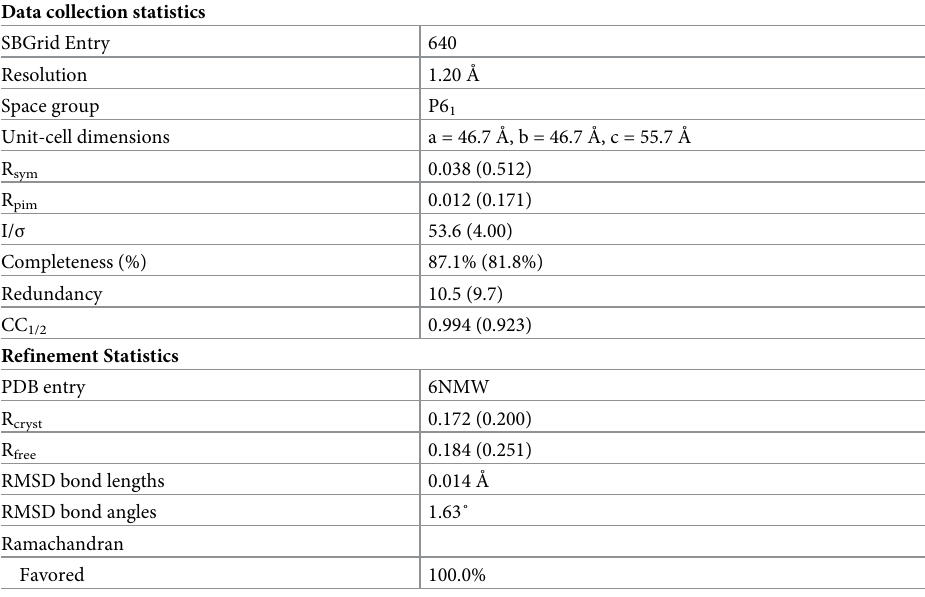
Table 1. Data collection and refinement statistics for the Lyn SH3 domain. Values in parentheses correspond to the highest resolution shell. For data collection, this corresponds to 1.22–1.20 Å resolution. For refinement, this corre- sponds to 1.26–1.20 Å resolution. Data are > 95% complete at 1.45 Å